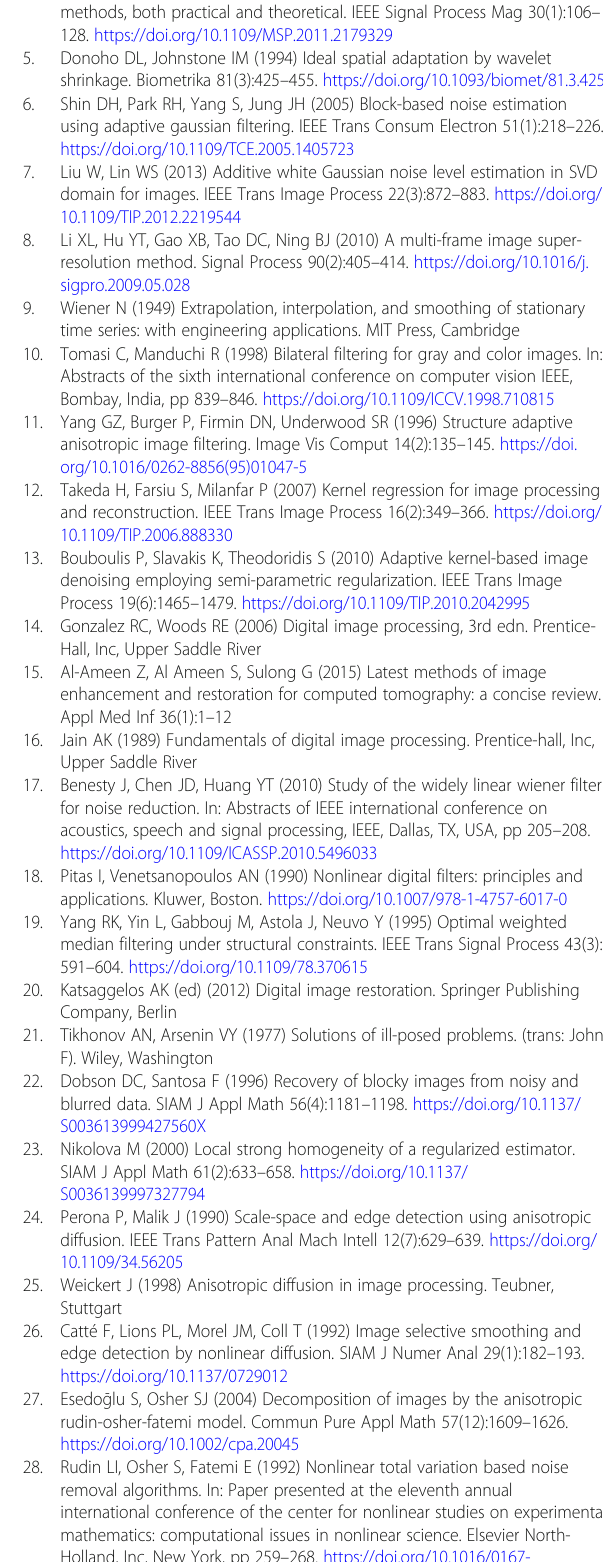
Abbreviations AWGN: Additive white Gaussian noise; BM3D: Block-matching and 3D filtering; CNN: Convolutional netural network; DnCNN: